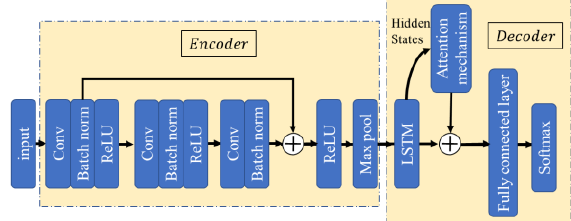
Fig 3. Overall structure of our method